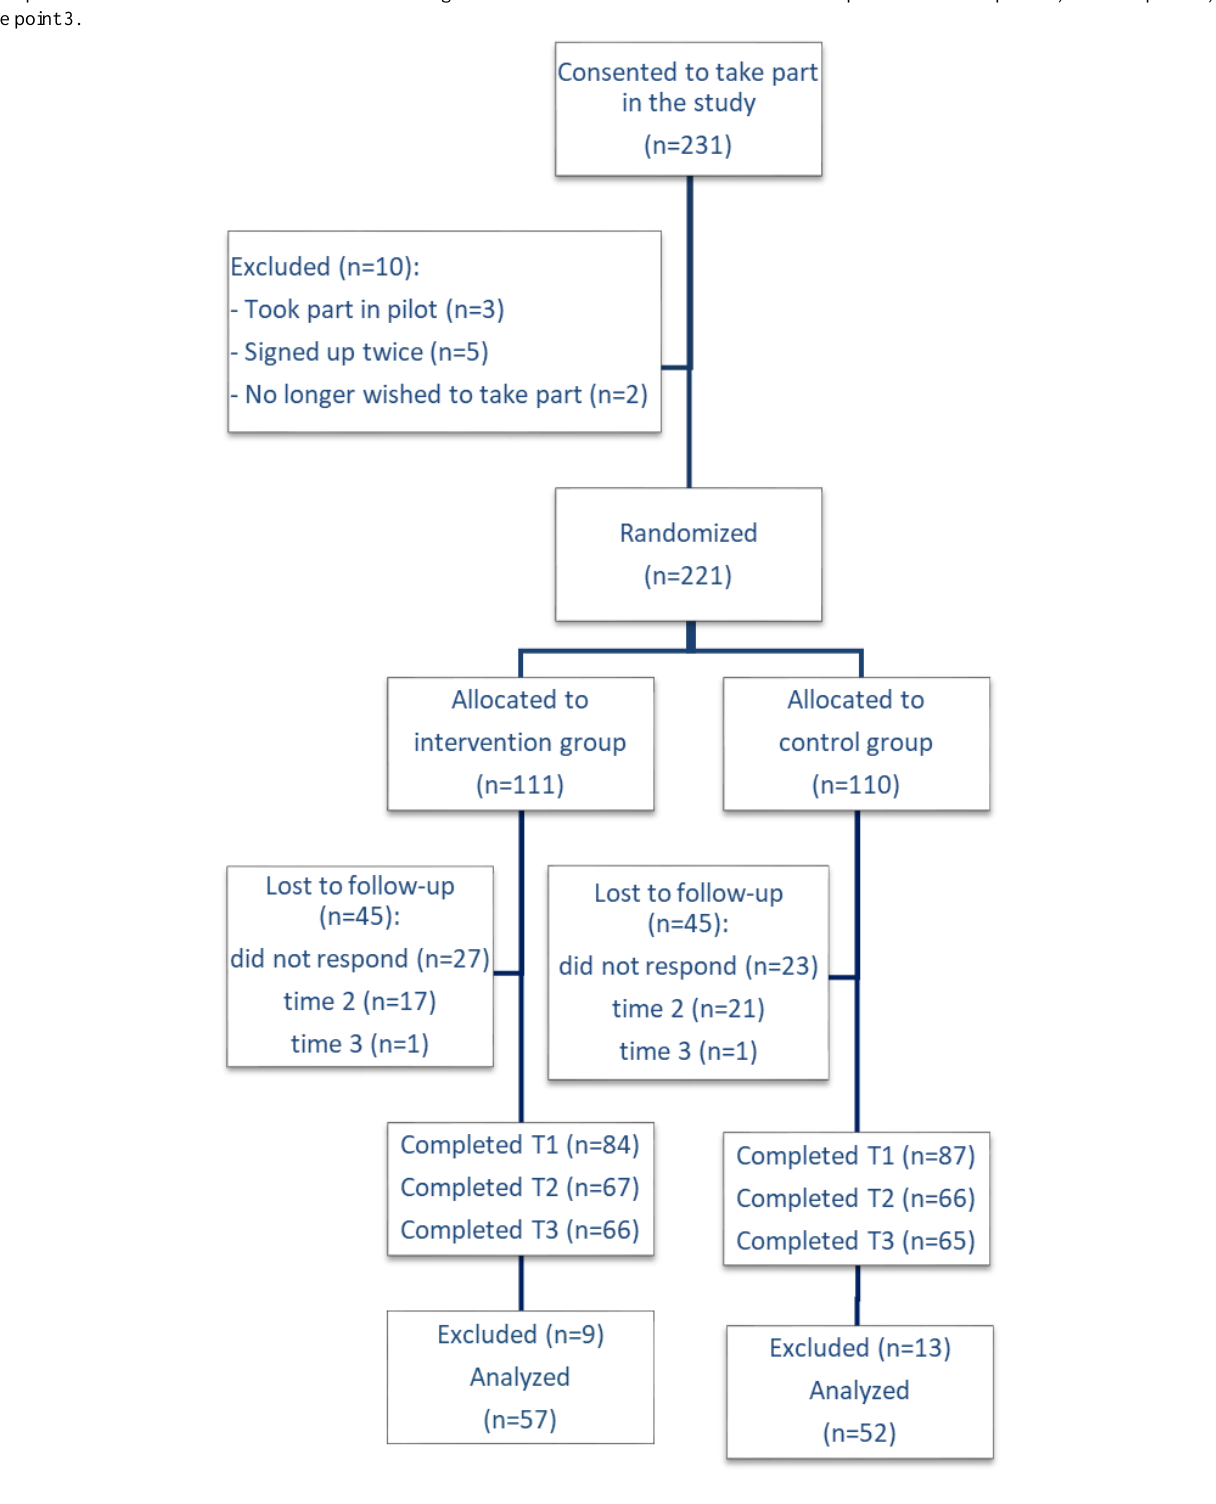
Figure 1. CONSORT (Consolidated Standards of Reporting Trials) flowchart of the pilot randomized controlled trial. A total of 18 participants were excluded because they did not complete the questionnaires at time point 1 (preintervention) and time point 2 (postintervention) within 48 hours, and 4 participants were excluded in the control arm for having received a link to the intervention before completion. T1: time point 1; T2: time point 2; T3: time point